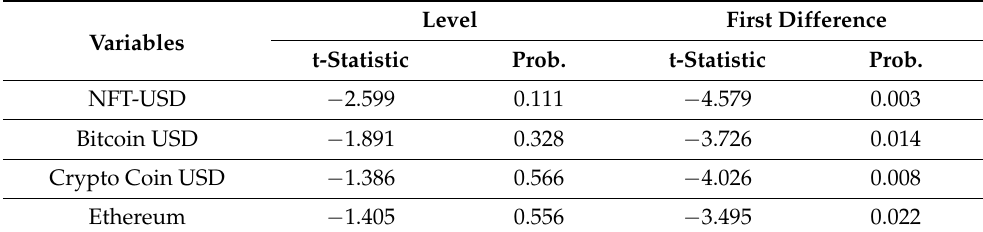
Table 3. Unit root test—ADF. Variables